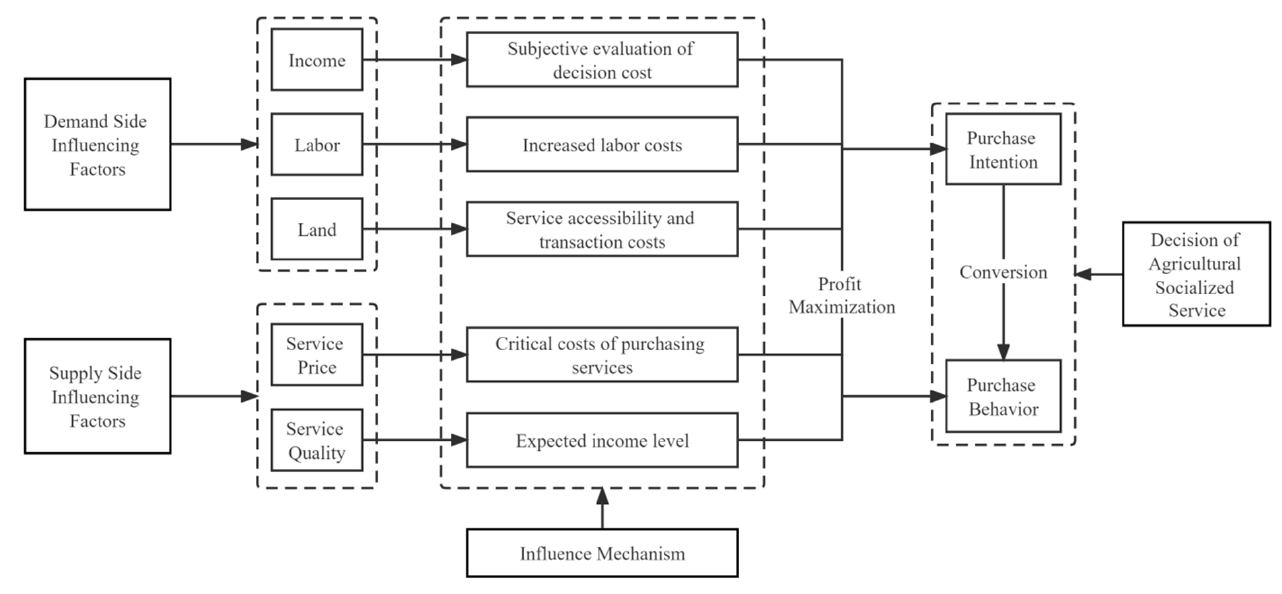
Figure 1. Theoretical analysis framework.